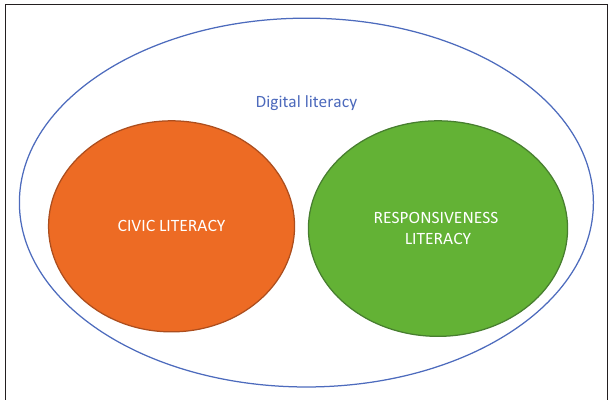
FIGURE 2: Reimagining digital literacy for digital citizen